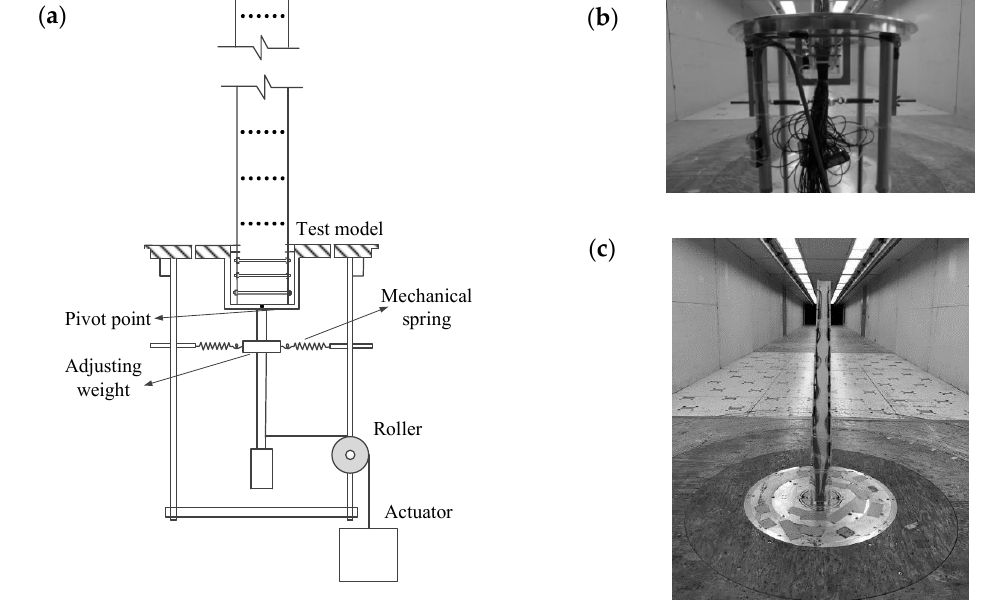
Figure 3. Schematic diagram of a forced vibration device: ( a ) a forced vibration test rig; ( b ) a forced vibration model in a wind tunnel; ( c ) the global view of the forced vibration model in a wind tunnel.